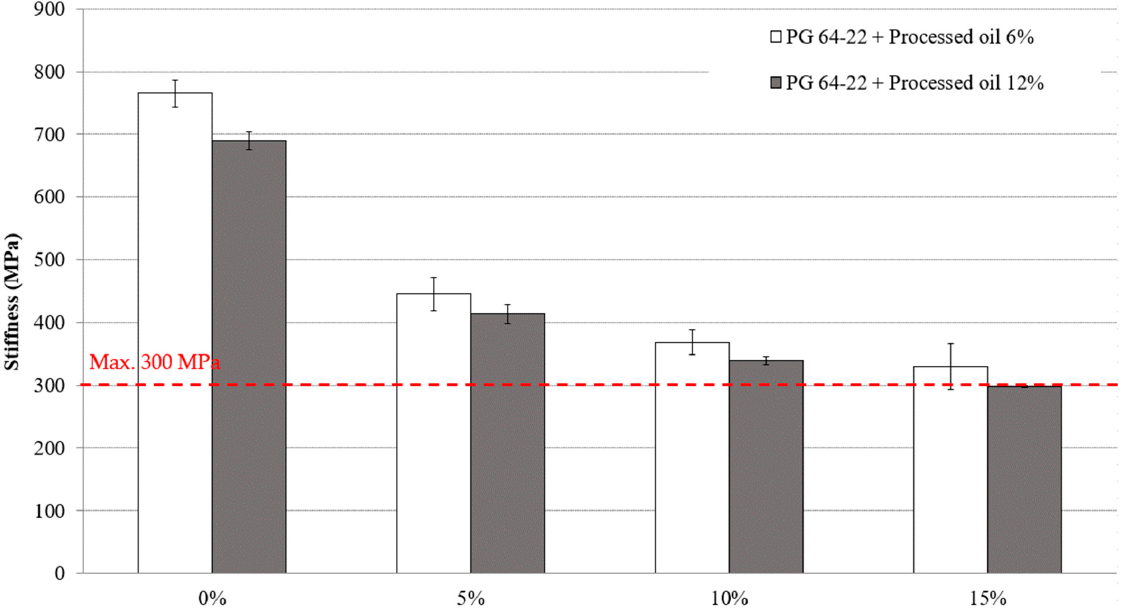
Figure 8. The effects of various CRM contents on the stiffness of RTFO + PAV aged PG 64-22 binder modified with 6% and 12% processed oil at − 24 °C.